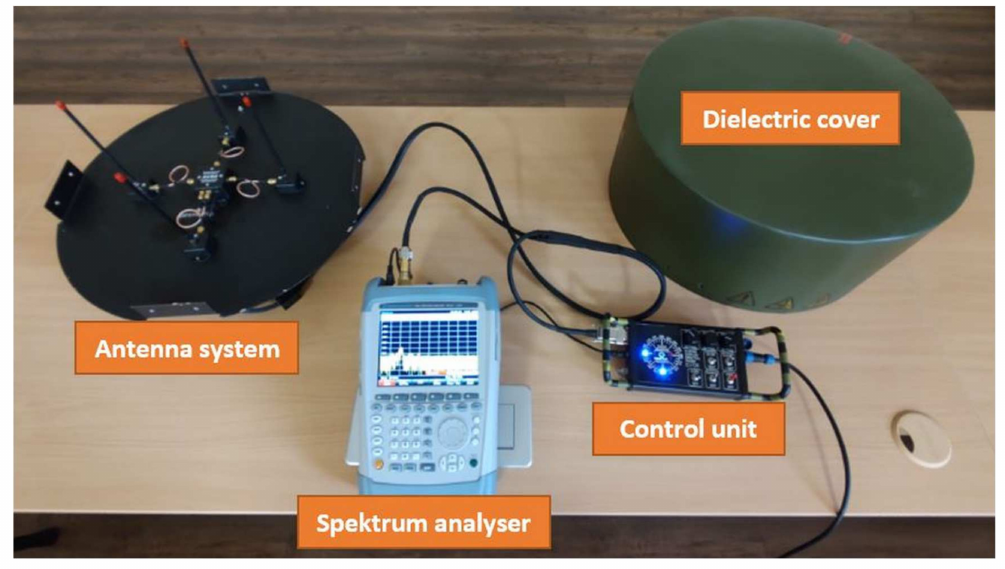
Figure 2. IDVOR radio signal targeting system designed for portable